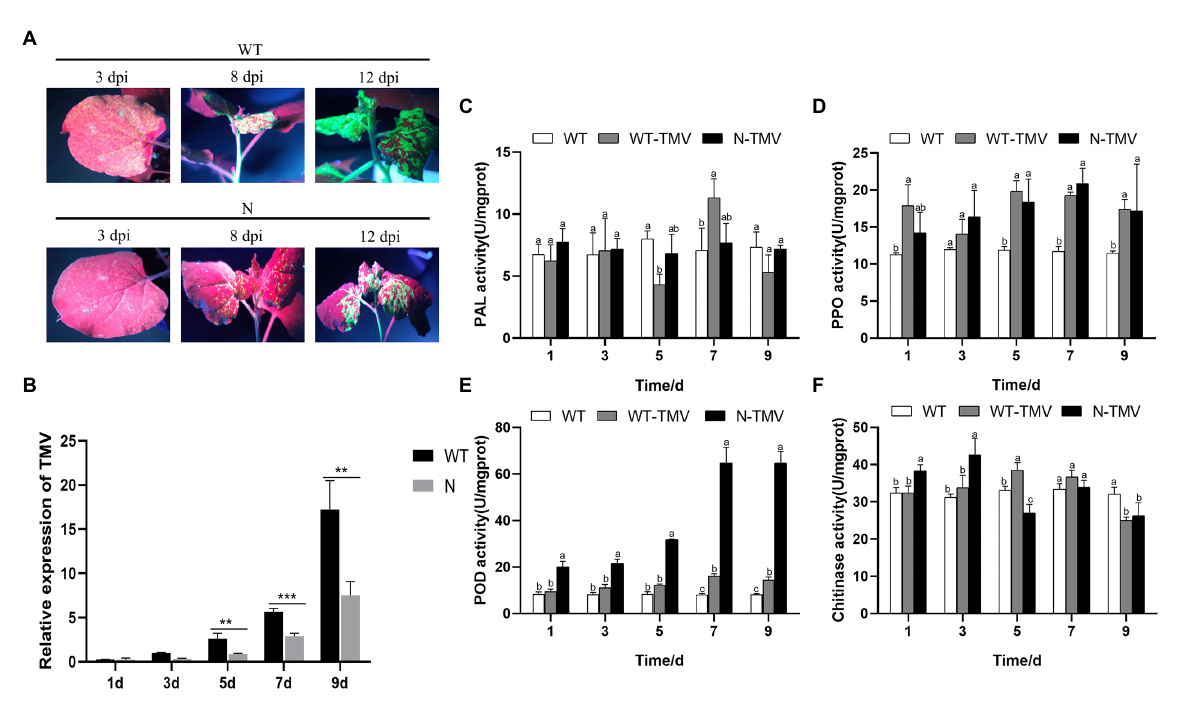
FIGURE 2 FTX271 transgenic tobacco exhibited significantly increased resistance to TMV and the activity of defense enzymes. (A) Green fluorescent signals representing viral replication in N and WT tobacco plants imaged at the 3rd, 8th, and 12th days postinoculation (dpi). (B) Detection of the expression of TMV at 1, 3, 5, 7, and 9 days (dpi) by qRT–PCR. The results are the mean ± SD from three independent experiments. Statistical analysis was performed using Student’s t test (*0.01 < p < 0.05, **0.001 < p < 0.01, *** p < 0.001). Activity of PAL (C) , PPO (D), and POD (E) and (F) chitinase in different treatments on Days 1, 3, 5, 7, and 9 after TMV inoculation (dpi). The experiment was repeated 3 times, and the data presented are the mean ± SD of three independent experiments. Asterisks indicate significant differences between transgenic and WT N. benthamiana (Student’s t -test, *0.01 < p < 0.05, **0.001 < p < 0.01, *** p < 0.001). WT, wild type; WT-TMV, wild type inoculated with TMV, N-TMV: transgenic tobacco inoculated with